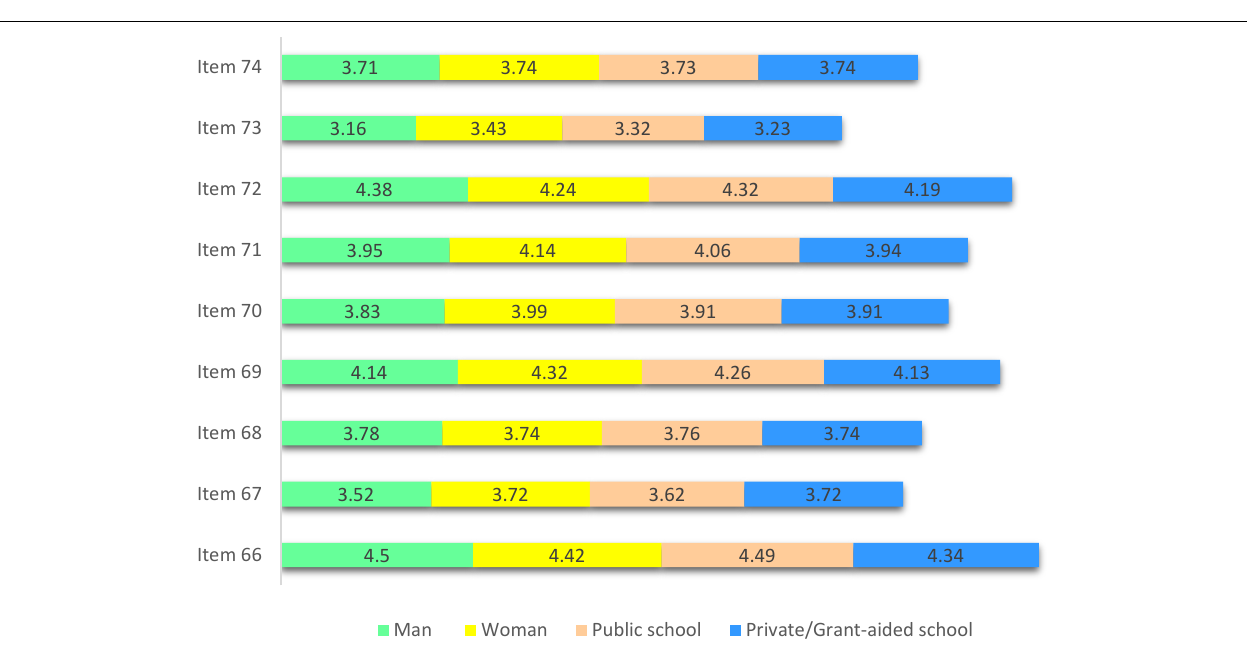
FIGURE 4 | Average values of teachers, according to gender and tenure status of